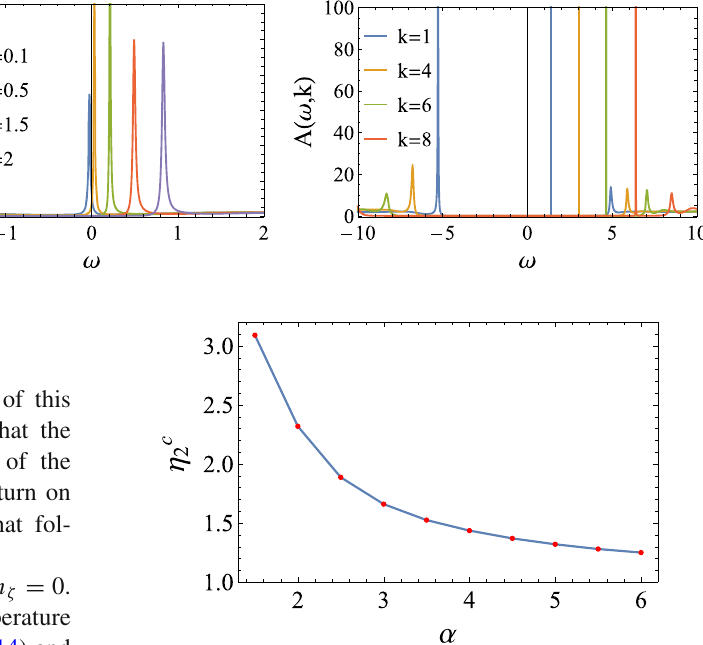
Fig. 4 The relation between α and η c